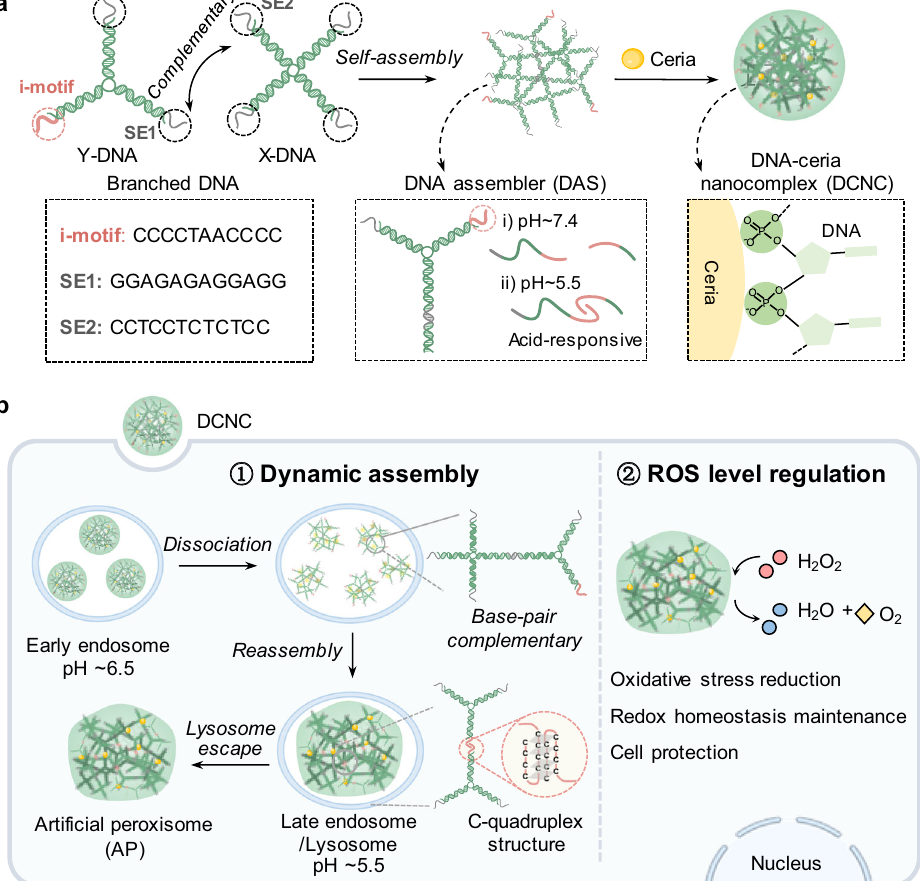
Fig.1|Constructionofarti fi cialperoxisomeviadynamicassemblyofDCNCinalivingcell.a Moleculardesignandself-assemblyofDCNC.SE,stickyend. b Intracellular lysosomal acidic condition-induced assembly of DCNC into arti fi cial peroxisome. ROS reactive oxygen